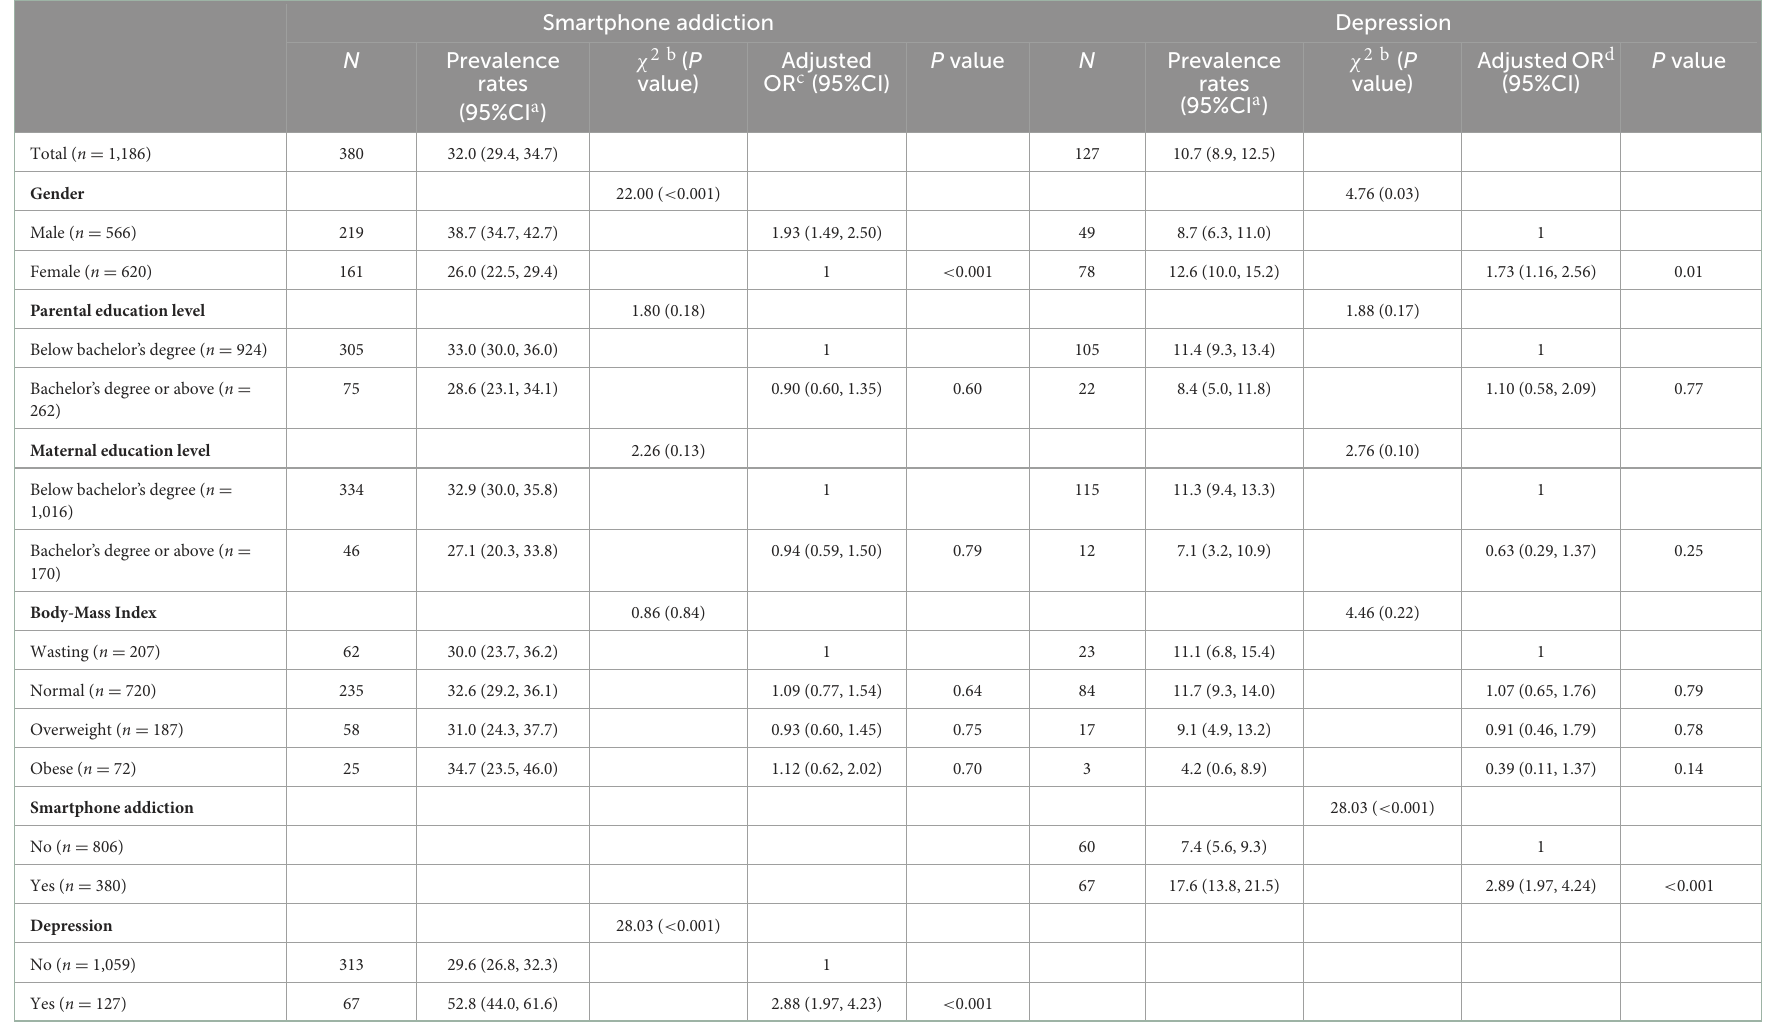
TABLE 2 The detection rates and predictors for smartphone addiction and depression in the baseline among respondents who responded to both